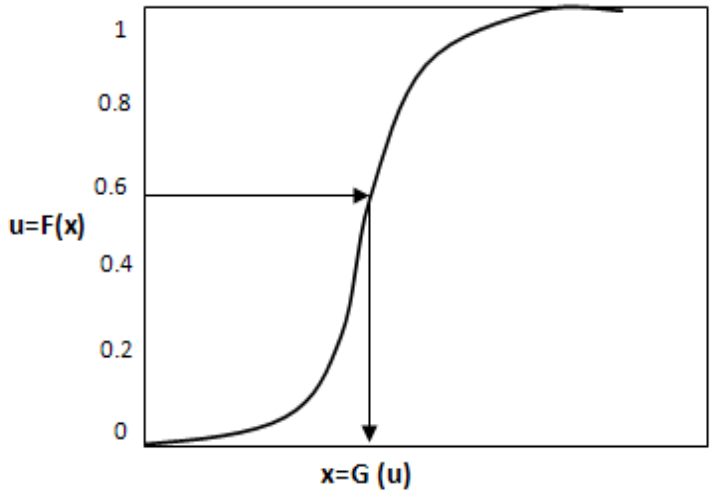
Figure A1. The principle of Monte Carlo